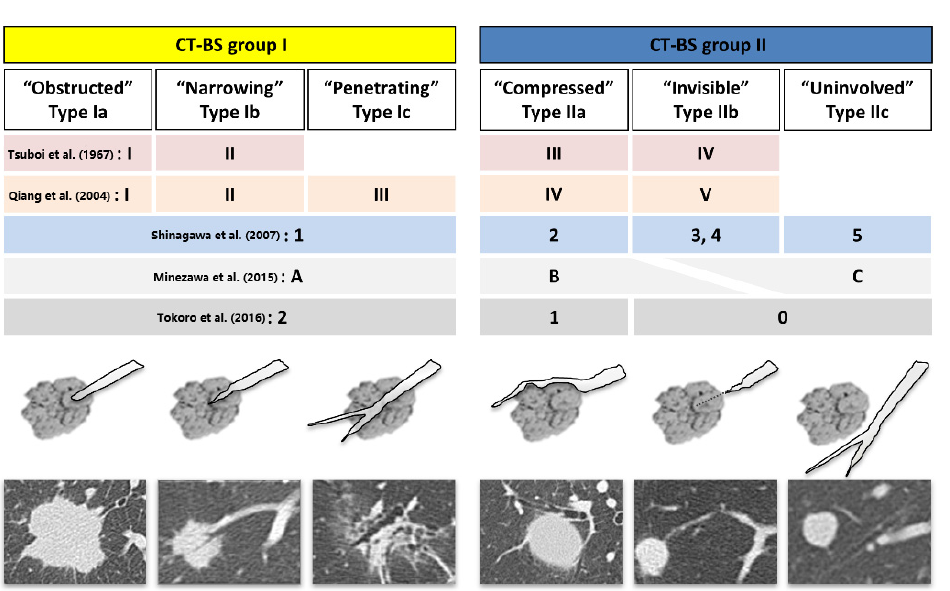
Figure 1. Schematic of classification of bronchus types, integrated with previously reported classifications. CT-BS, computed tomography bronchus sign [10,18,20,21,25].